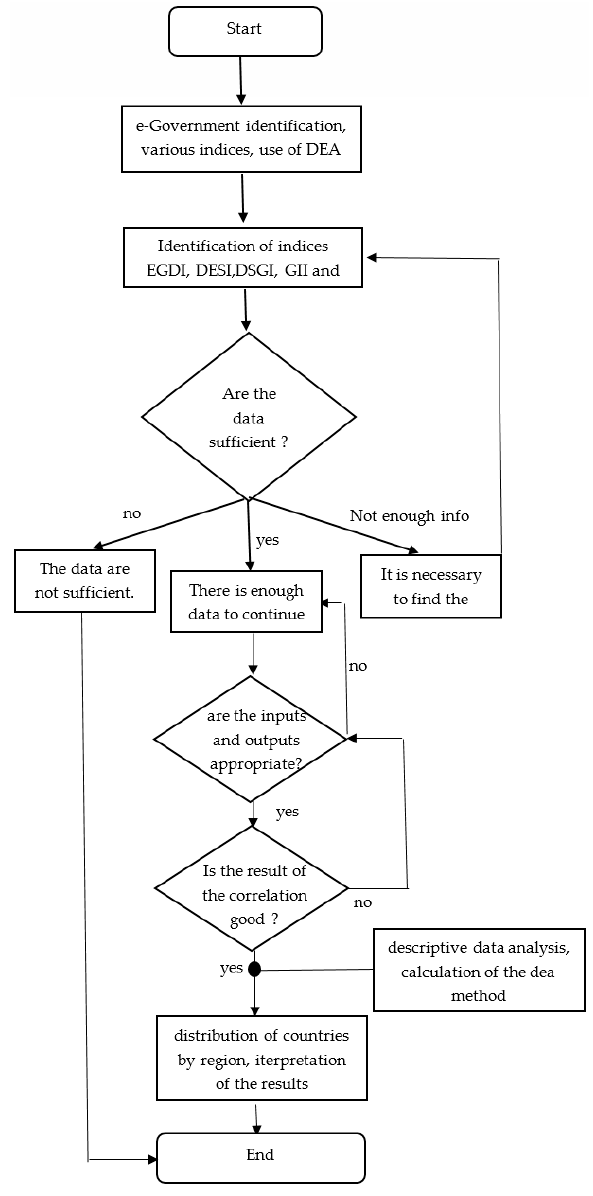
Figure 3. Methodology. (Source: own processing).